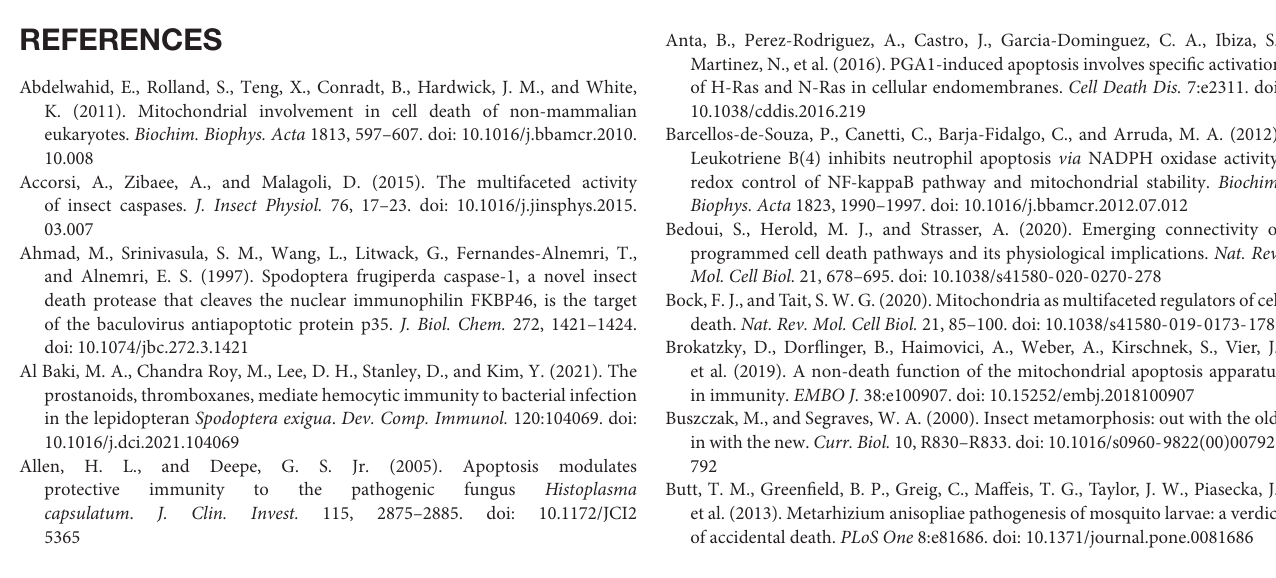
Supplementary Table S1 | Concentration of selected eicosanoids in the hemolymph of G. mellonella larvae after infection with C. coronatus- row data. The measurements were performed using ELISA tests. Control, non-infected, healthy larvae; F24, larvae sampled immediately after 24-h exposure to C. coronatus sporulating colonies; F48, larvae sampled 24 h after 24-h